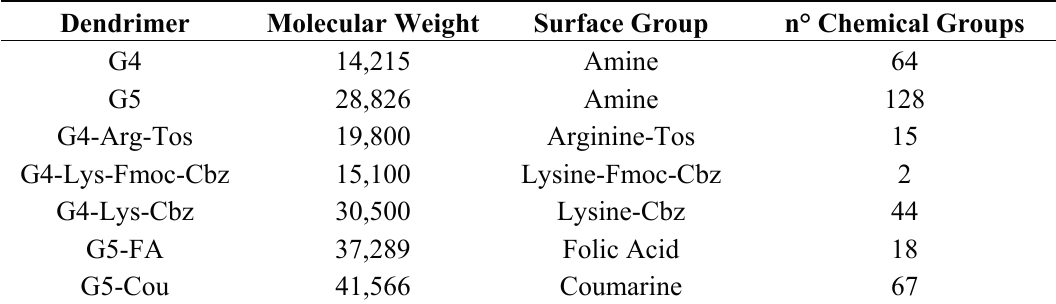
Table 2. Characterization of the synthesized PAMAM G4 and G5